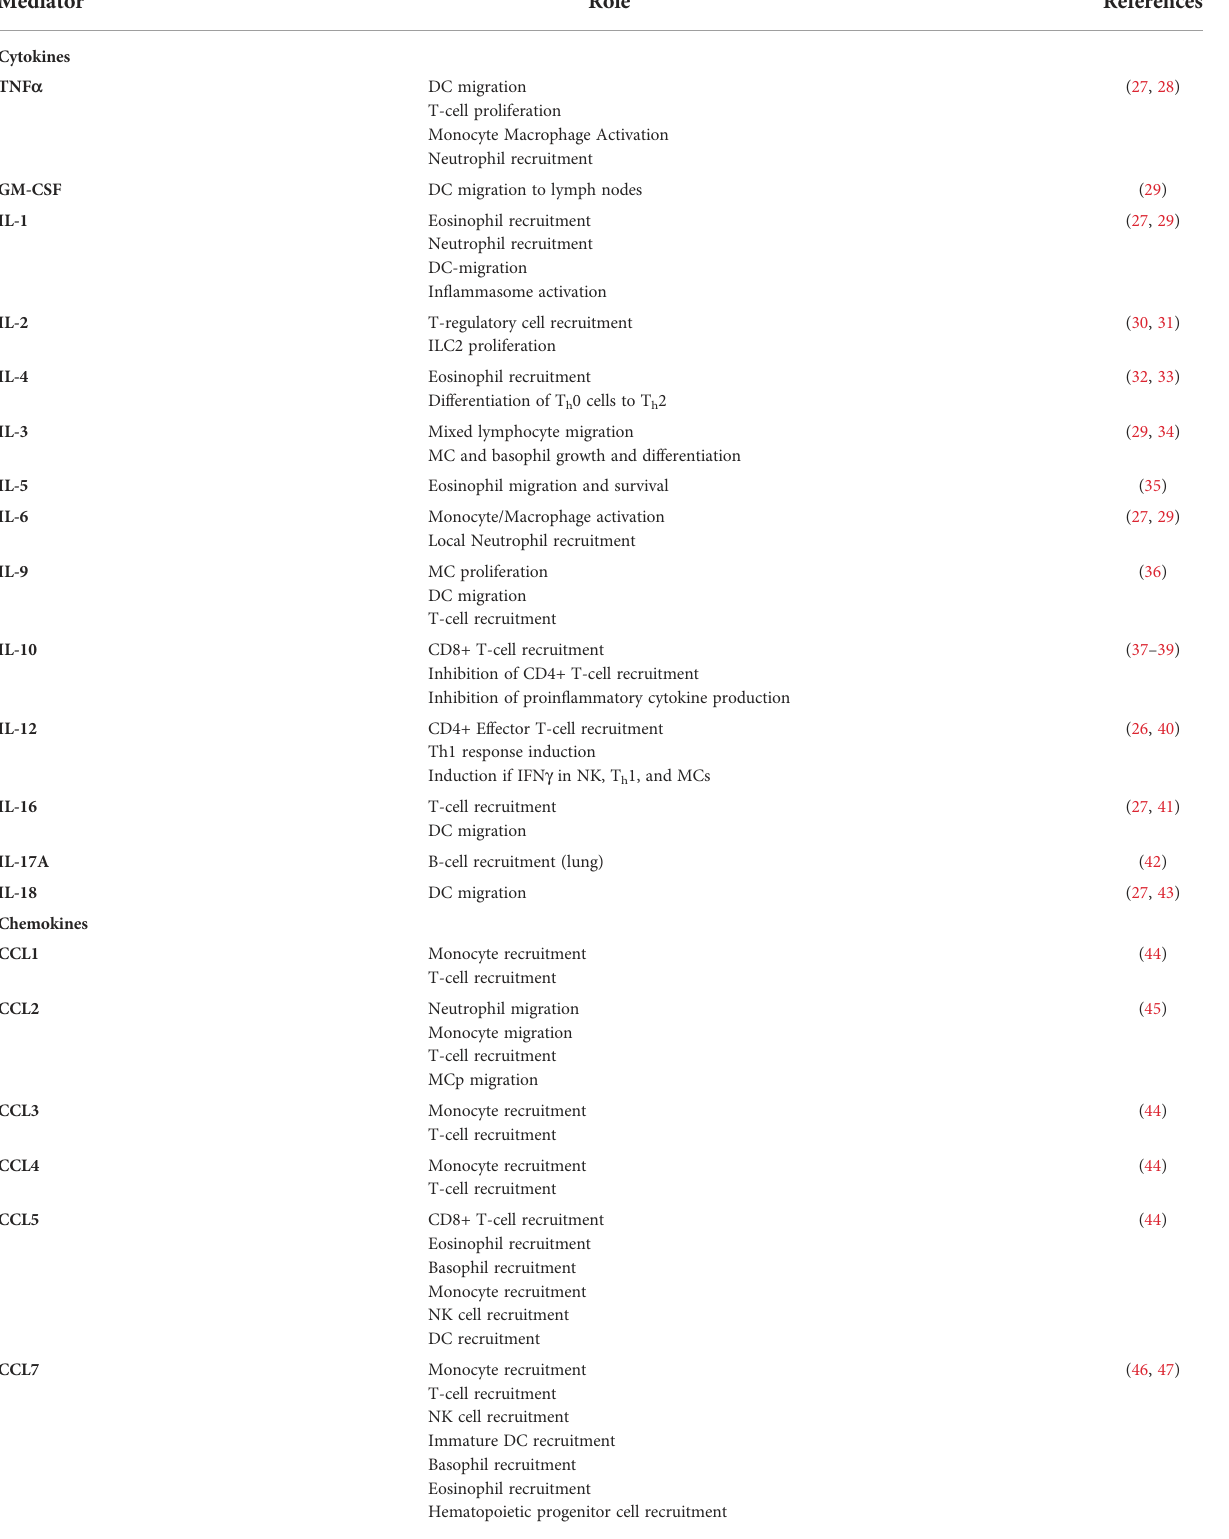
TABLE 1 Key mediators and chemoattractants released by mast